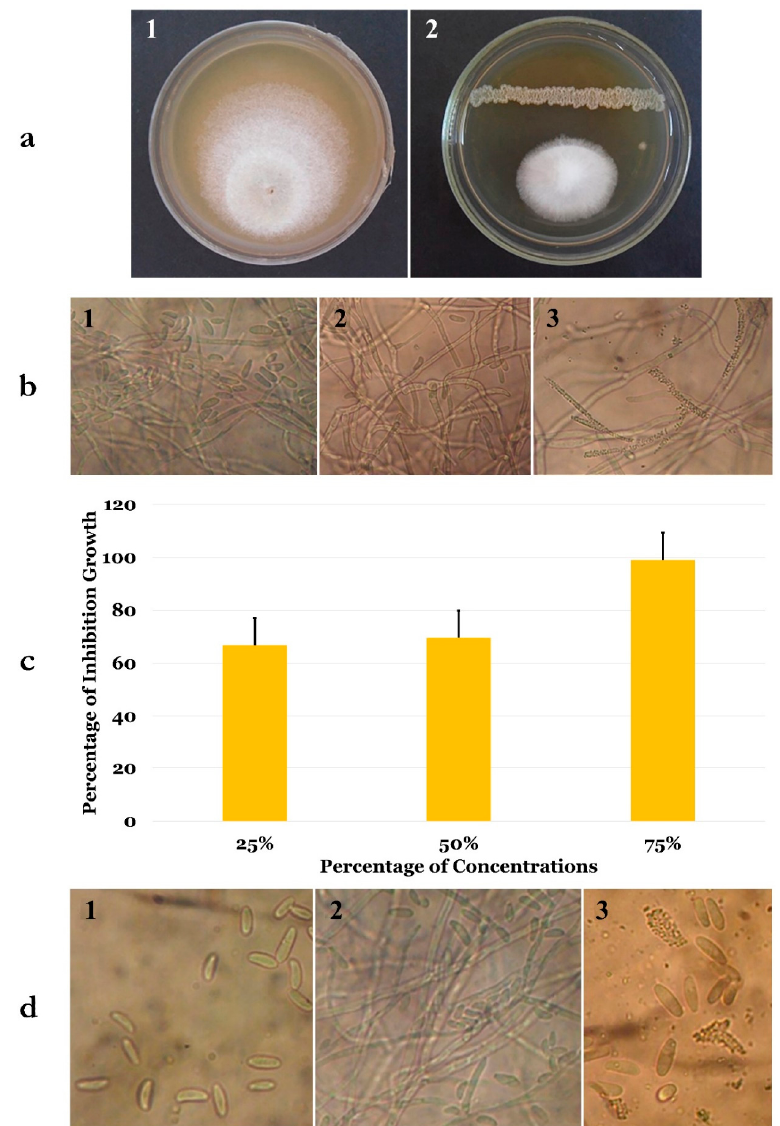
Figure 2. ( a ) Antifungal activity of bacterial isolate OEE1 against Fusarium solani after 6 days of incubation at 25 °C. ( b ) Microscopic examination (×400) of F. solani mycelia after confrontation assay with bacterial isolate OEE1 for 6 days at 25 °C (from left to right—negative control, cytoplasm vacuolization and mycelial lysis). ( c ) Inhibition percentages of different concentrations of the isolate OEE1 culture filtrate on F. solani mycelial growth at 25 °C after 6 days of incubation. ( d ) Microscopic examination (×400) of culture filtrate inhibition on conidia germination after growth at 25 °C (from left to right— F. solani conidia at the time of incubation, negative control after 6 days of incubation and conidial lysis after 6 days of incubation with a 75% culture